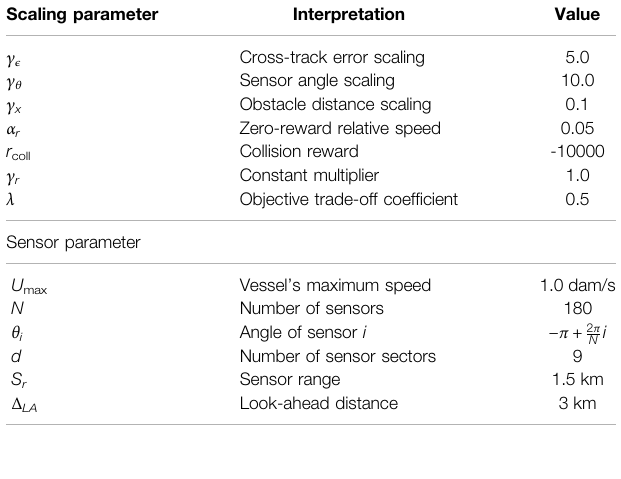
TABLE 2 | Description of parameters in the initial reward function. The vessel ’ s maximum speed is denoted in decameters per second (1 dam (cid:1) 10